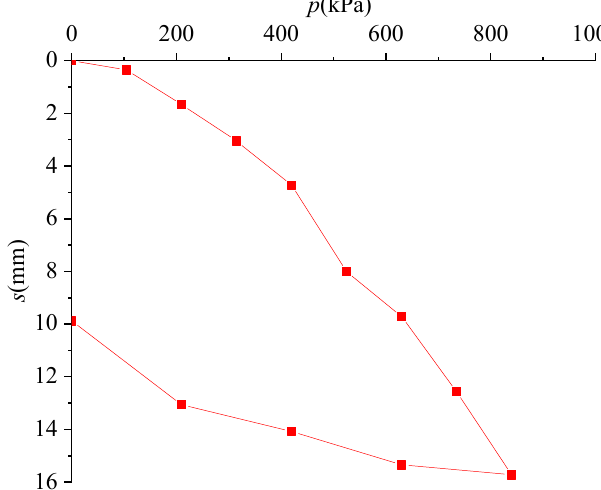
Figure 13. p – s curve by shallow plate loading test in 15# building. The p – s curve fitting equation is s / p = 0.000908 s + 0.006, where a = 0.006 and b = 0.000908. The initial tangential modulus E 0 of the gravel layer is 197.66 MPa, and the ultimate bearing capacity P u of the gravel layer is 1101.32